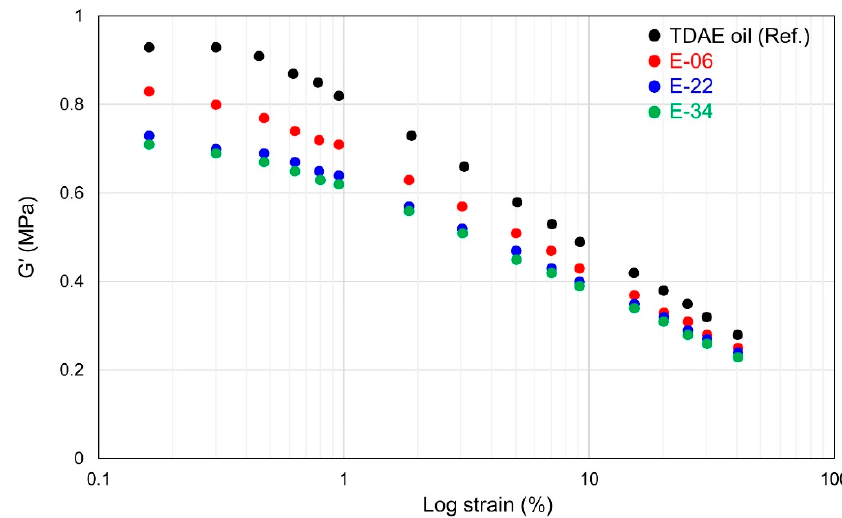
Figure 2. Strain dependences of the shear storage modulus ( G ′ ) for the compounds. Table 4. Payne effect.